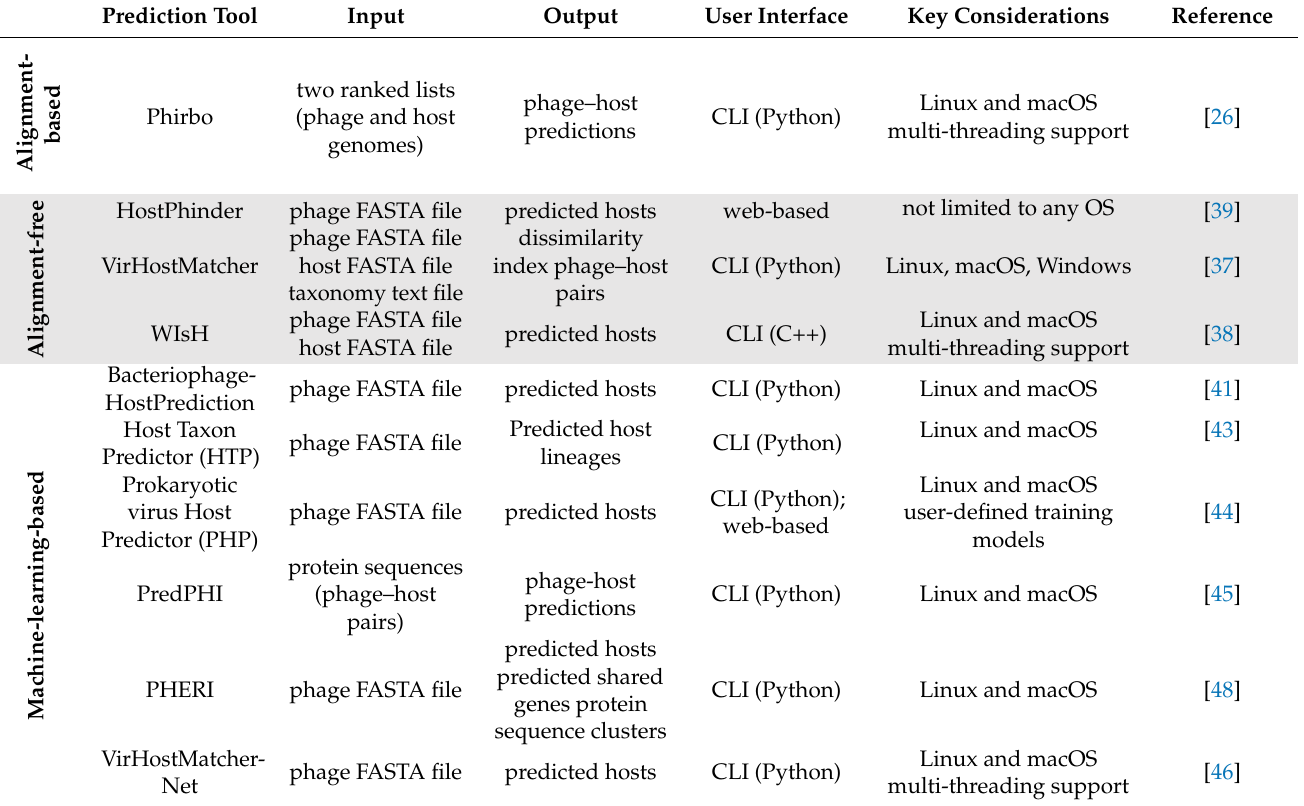
Table 1. Computational methods in predicting bacteriophage host